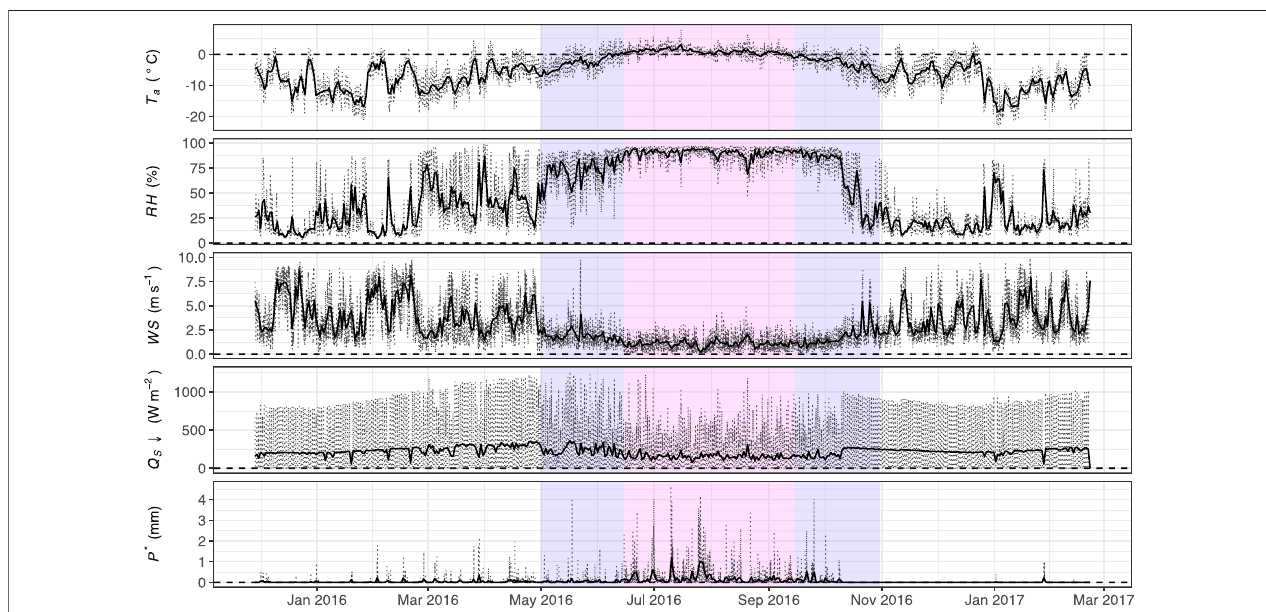
FIGURE 4 | Meteorological data used in the modelling study. The dotted lines are hourly values and the solid black lines are daily average values. These data were collected from instruments installed 2 m above the debris surface at NCN-AWS. The background colours indicate the season, as de fi ned by Government of Nepal (2021): white is winter, pink is monsoon, and blue is both pre-monsoon and post-monsoon.